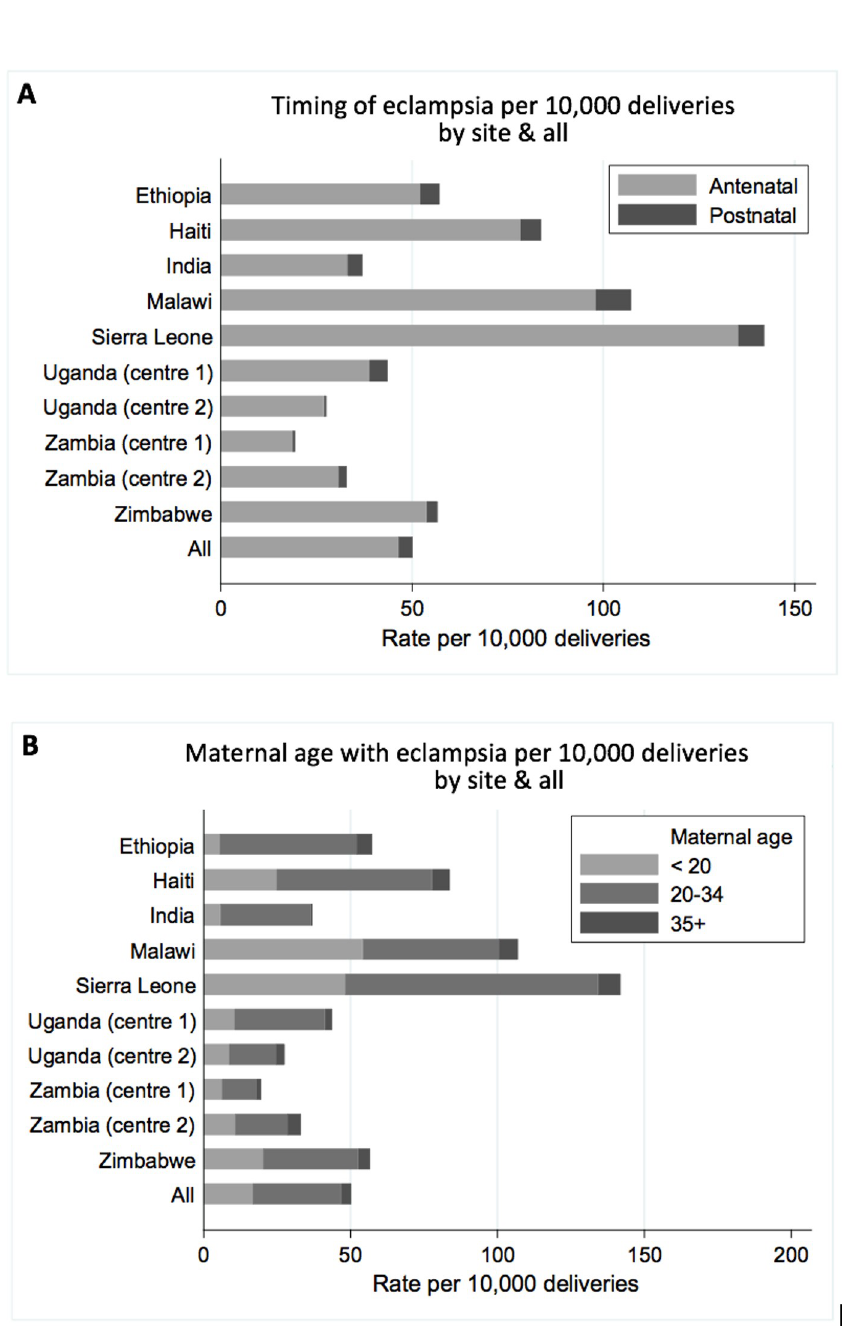
Fig 2. Characteristics of eclampsia by timing and maternal age by site. Data shown by timing of eclampsia (A) and maternal age (B). Corresponding numbers are given in S4 Table.